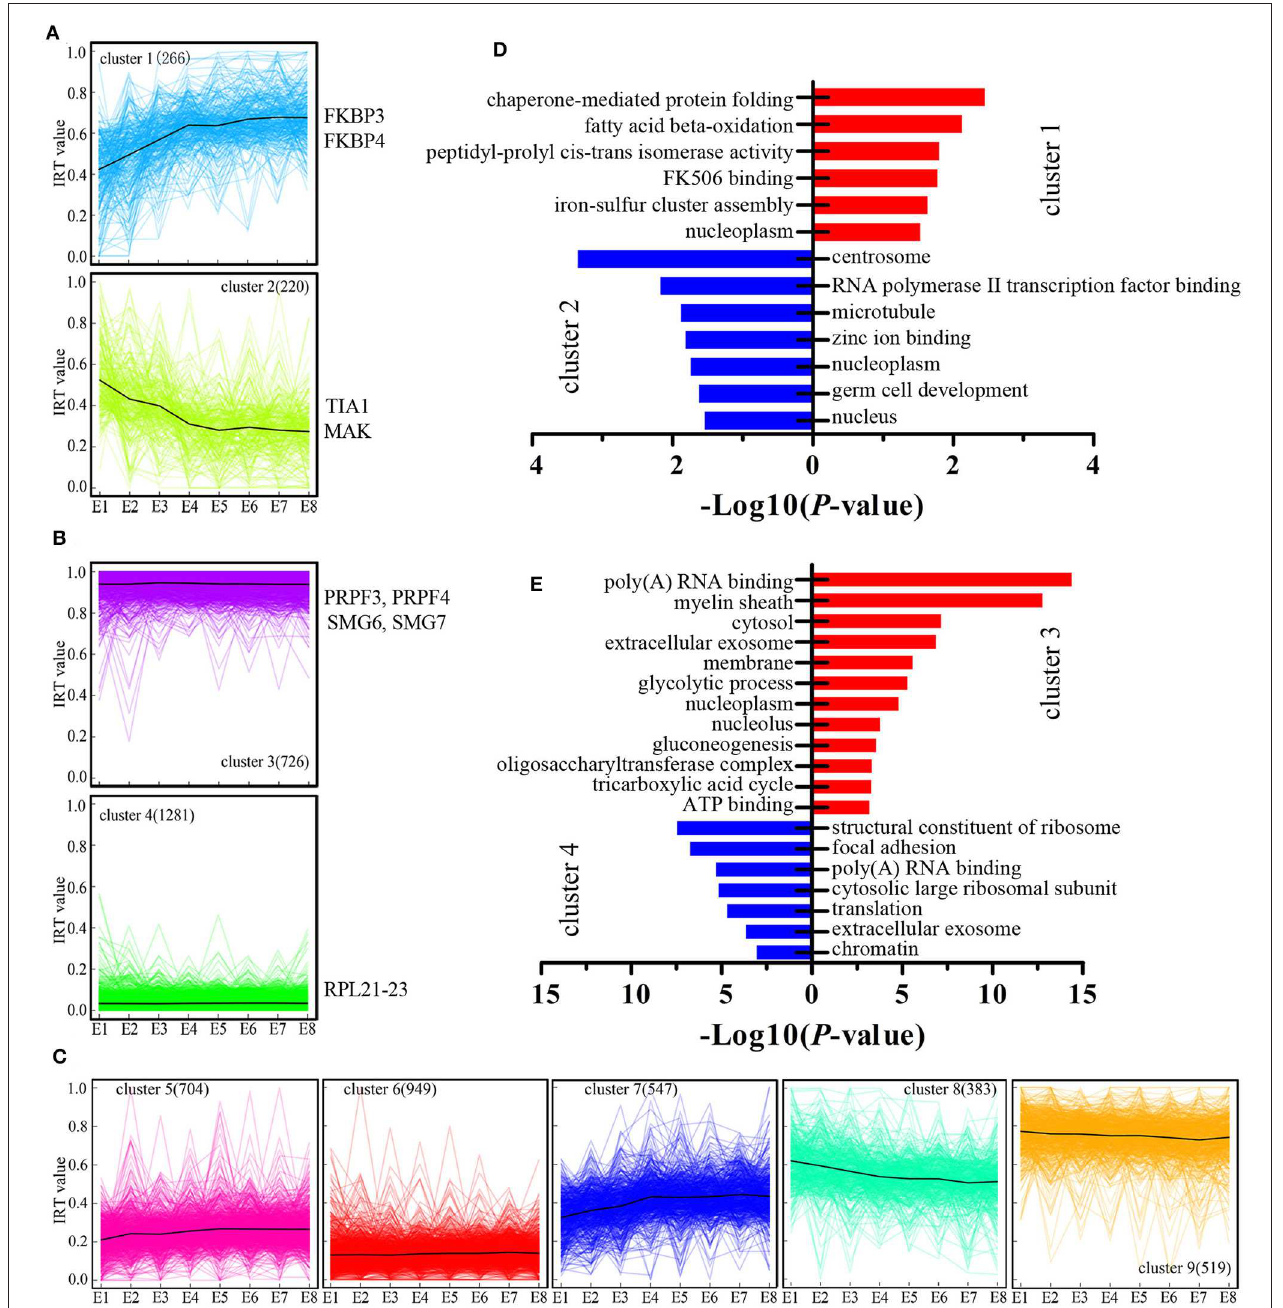
FIGURE 3 | Cluster analysis of IR during chicken embryo development. (A–C) K-means cluster analysis based on IR-containing transcript values during the eight stages of embryo development. The number of IR-containing transcripts in each cluster is showed within parentheses. On the vertical axis, IRT value represents the IR-containing transcript values. Some representative known genes for each cluster were present near the cluster. (D,E) DAVID analysis of enriched GO terms for each gene cluster.